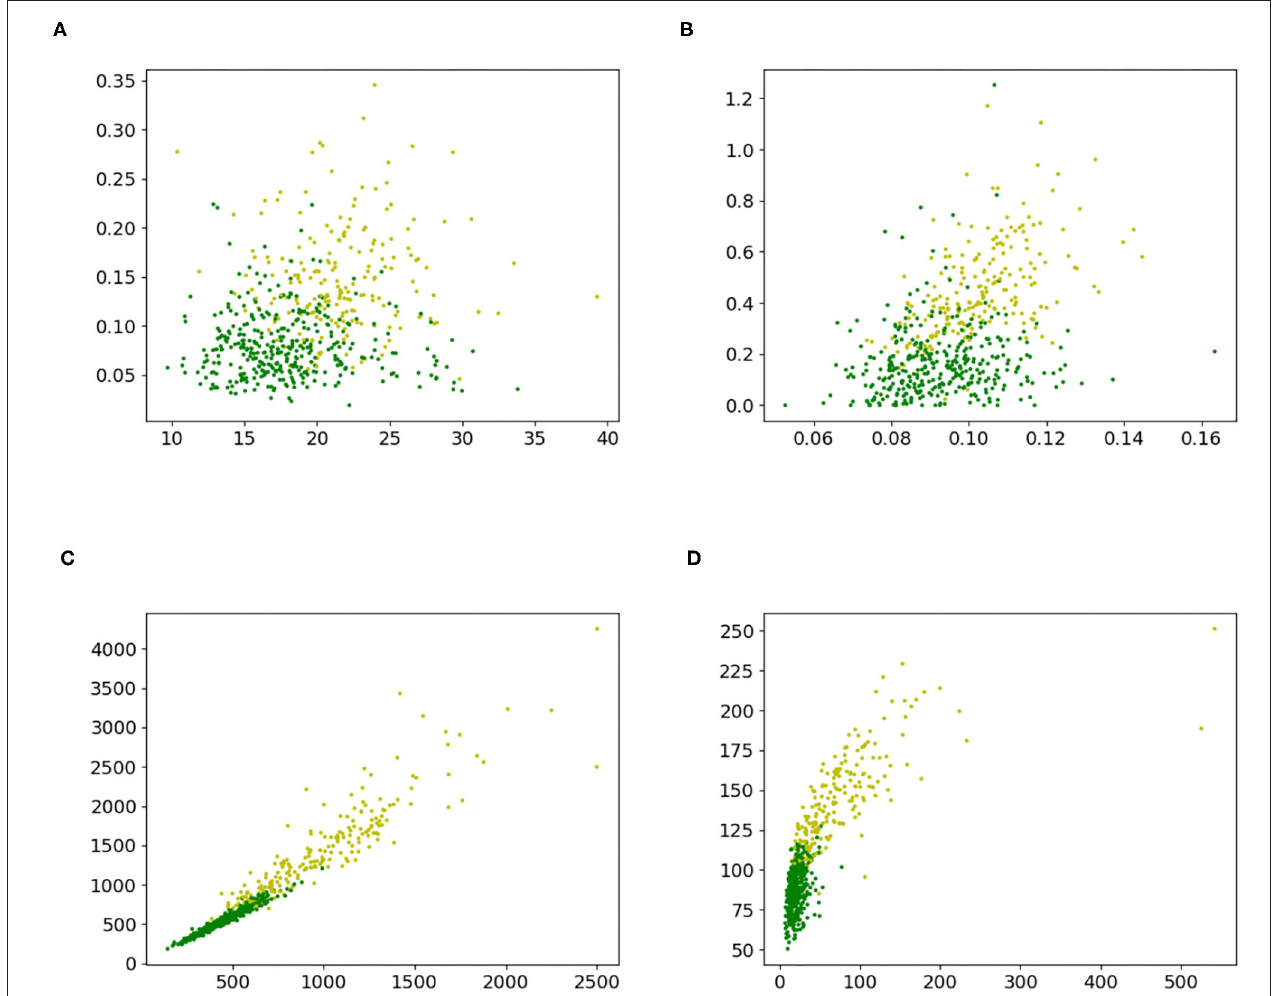
FIGURE 5 | 2-D datasets extracted from the breast cancer dataset to compare proposed iterative optimization with a grid search. (A) Features 2 and 6, (B) features 5 and 27, (C) features 4 and 24, and (D) features 14 and 23.